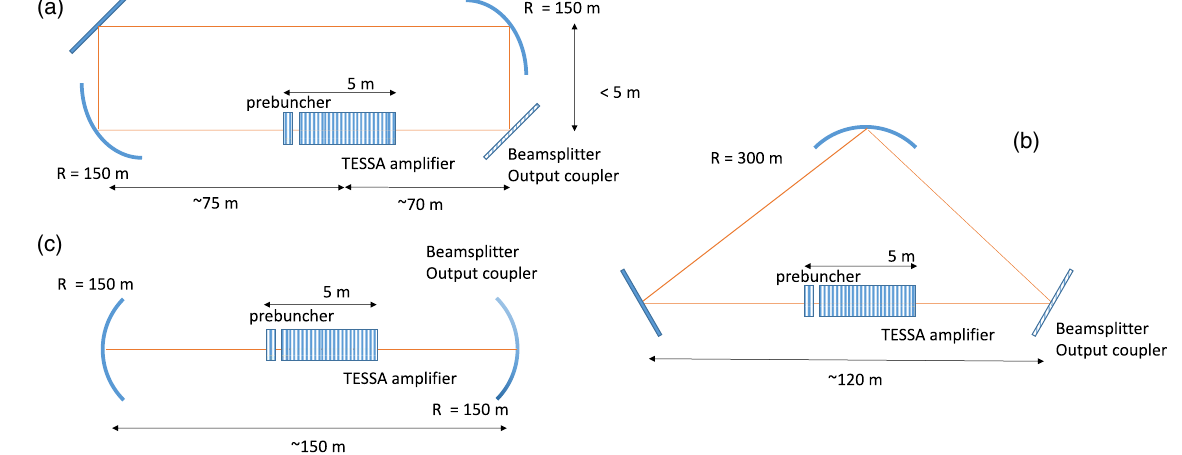
FIG. 8. Oscillator configuration. Near concentric resonator design. Design (a) is a ring cavity and allows the injection of the igniter pulse. Design (b) has less mirrors but presents some challenges for the injection. Design (c) is a ringlike hemispheric resonator with only one curved